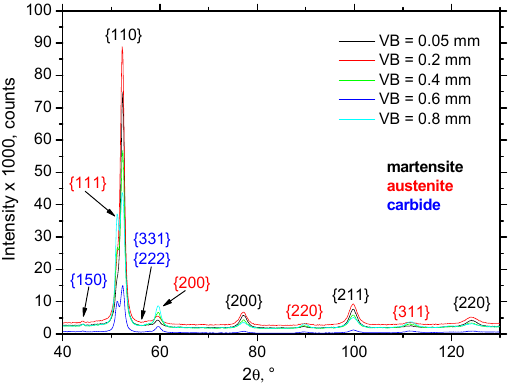
Figure 10. Diffraction patterns from surfaces.